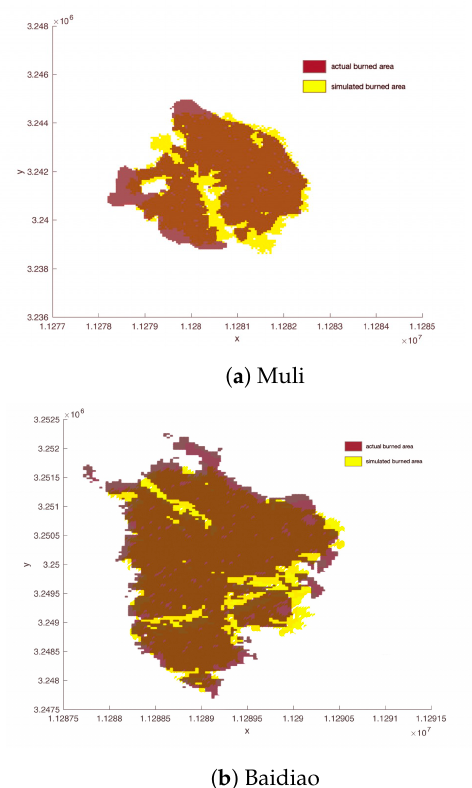
Figure 9. Comparison between the actual fire area and the simulation results in Muli and Baidiao